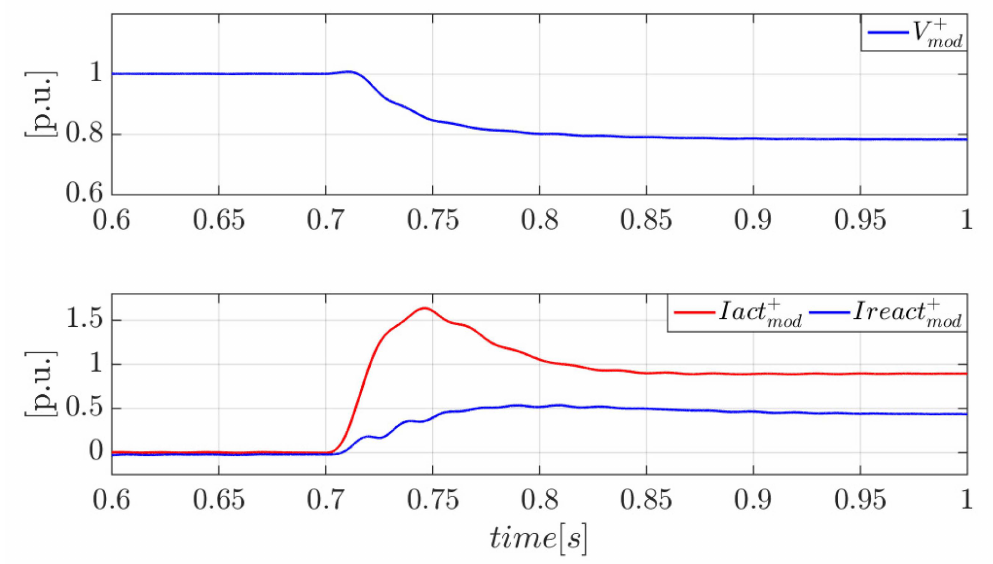
Figure 16. GFM converter positive sequence voltage and currents during a balanced fault with 0.22 p.u. depth.